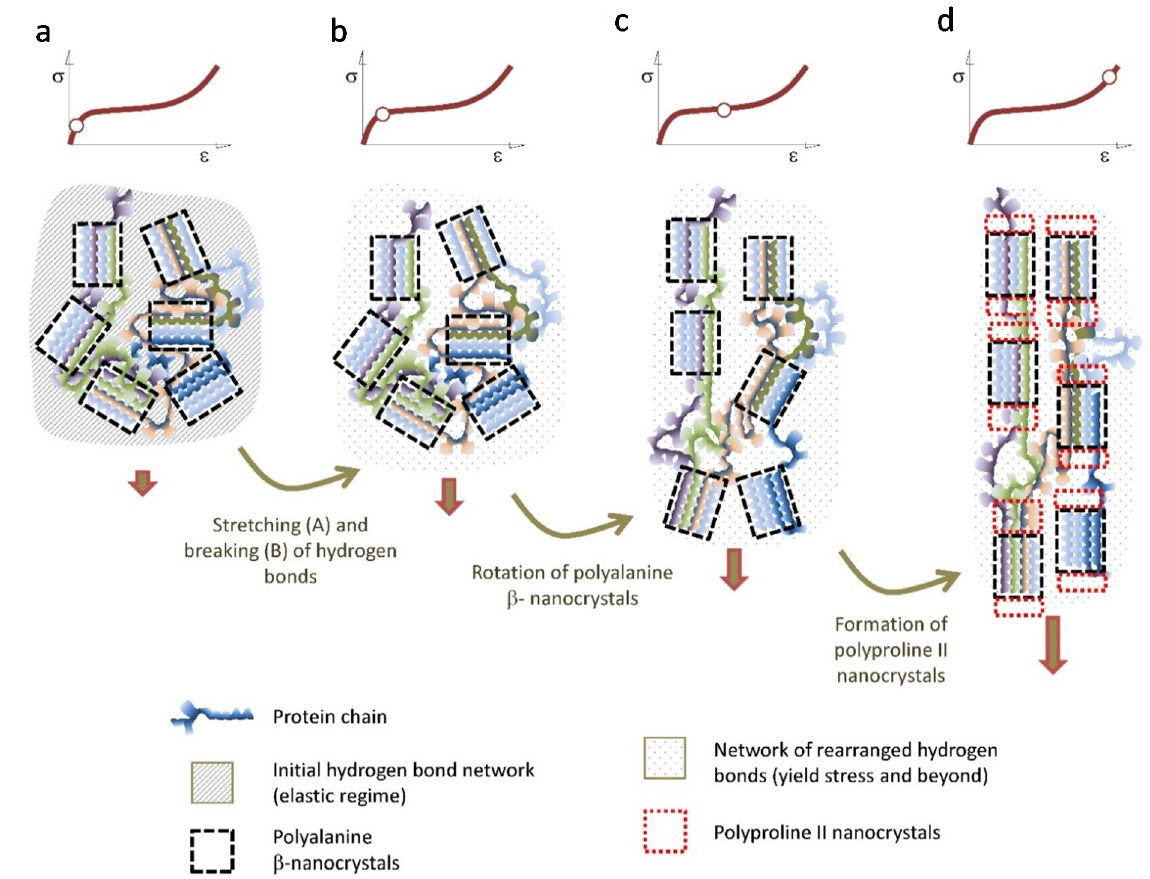
Figure 6. Scheme of the proposed deformation micromechanisms of the Entelegynae major ampullate gland silk fibers. The hydrogen bonds are stretched in the elastic regime ( a ) and begin to break upon reaching the yield stress ( b ). The breaking of the initial network of hydrogen bonds is followed by the rotation of the polyalanine β -nanocrytals that tends to get oriented with the macroscopic axis of the fiber ( c ) When the maximum possible orientation of the polyalanine β -nanocrystals is attained, polyproline II nanocrystals start to form at the ends of the β -nanocrystals ( d